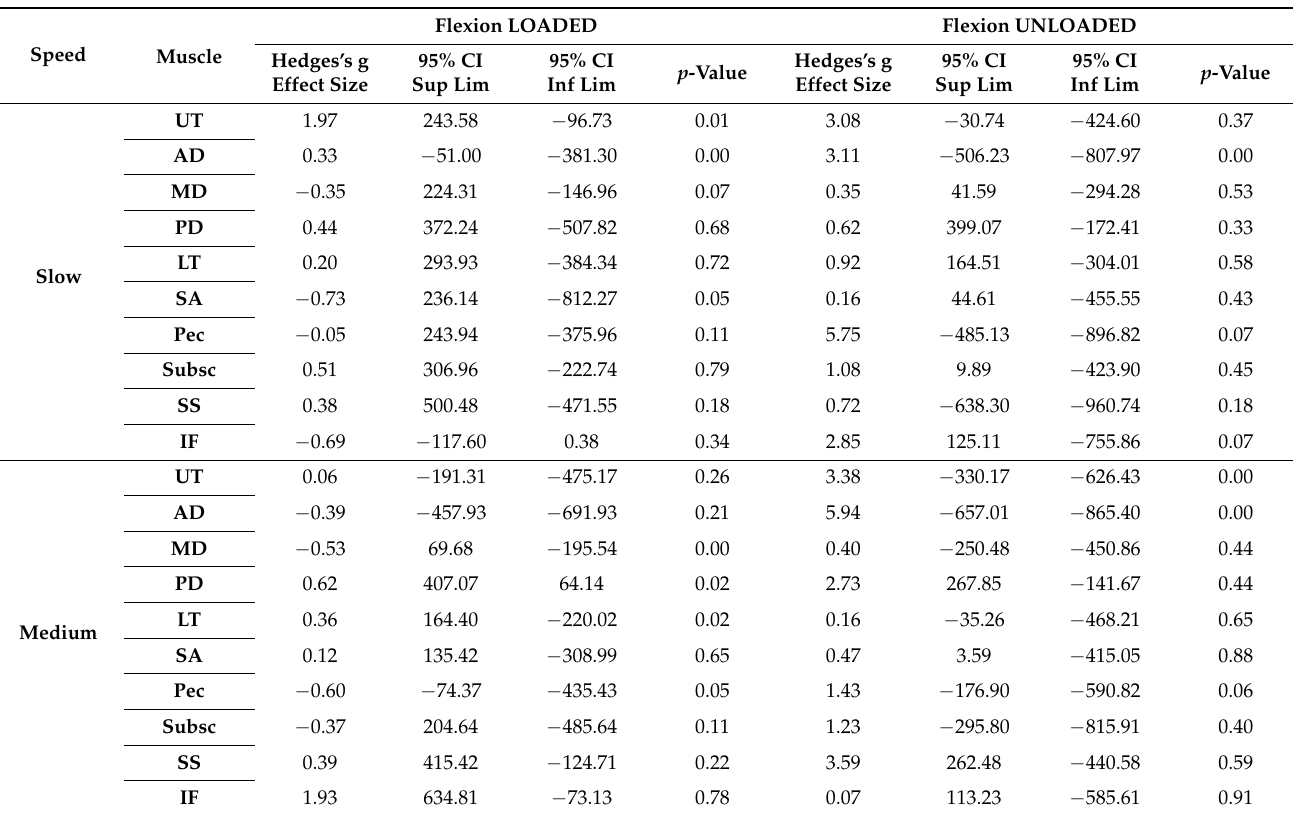
Table 2. Comparative statistics of EMG onset time of activation (ms) during flexion before and after standardized physio- therapy treatment for SIS movement at slow, medium and fast speeds; loaded and unloaded